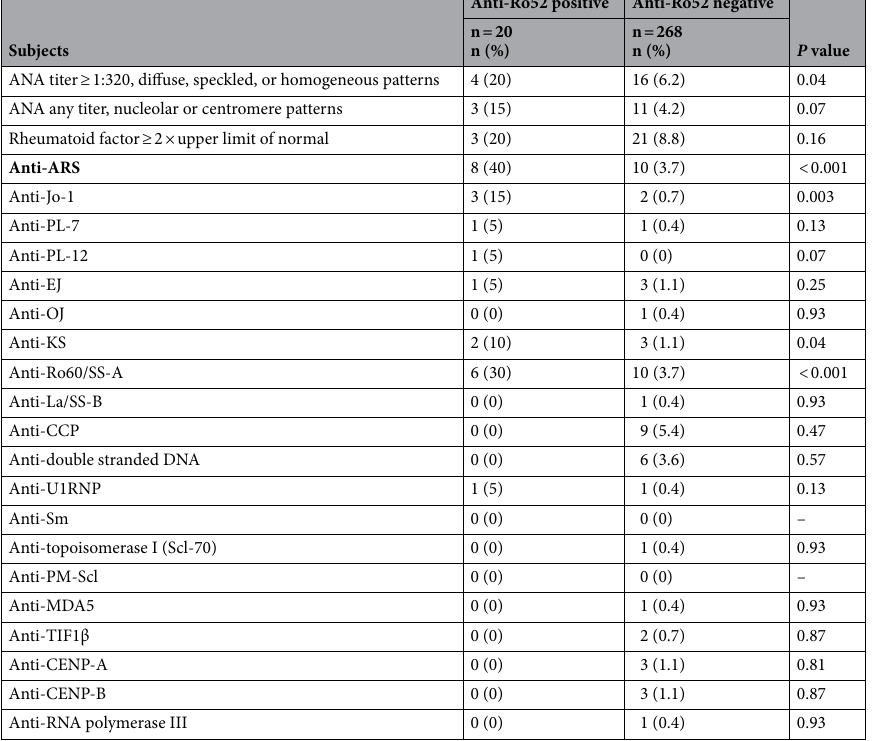
Table 2. Antibodies co-existing with anti-Ro52/tripartite motif-containing 21 antibodies (anti-Ro52). Data presented as frequencies (%). Ro52: Ro52/tripartite motif-containing 21; ANA: anti-nuclear antibody; ARS: aminoacyl-tRNA synthetases; CCP: cyclic citrullinated peptide; MDA5: melanoma differentiation-associated gene 5; TIF1: transcriptional intermediary factor 1; CENP: centromere protein. P value: anti-Ro52 positive vs. anti-Ro52